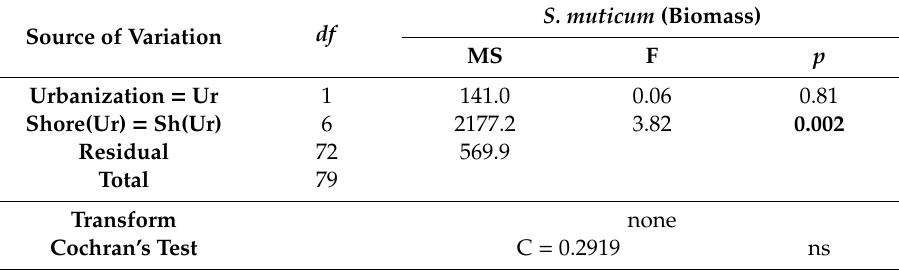
Table 5. ANOVAs testing for di ff erences on the biomass of S. muticum from urban and non-urban shores. Significant e ff ects are indicated in bold. ns: not